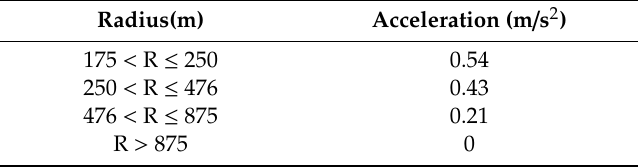
Table 5. Acceleration from midpoint to endpoint of circular